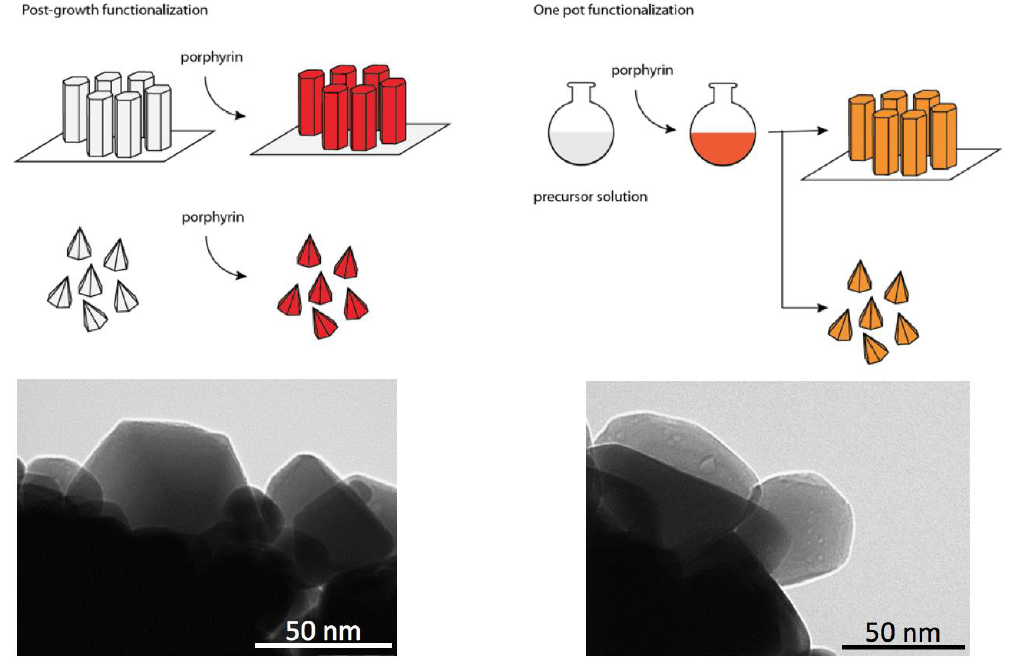
Figure 5. Processes of functionalization of ZnO nanorods or nanoparticles. In the post-growth process, the porphyrins are deposited from a liquid phase onto the prepared nanostructures. In the second approach, a one-pot preparation is achieved by mixing the porphyrins in the ZnO precursor solution. TEM Images show that in post-growth functionalization the hexagonal shape of the particle is preserved, while one-pot growth produces less regular inorganic structures with a more homogeneous and thinner organic layer.